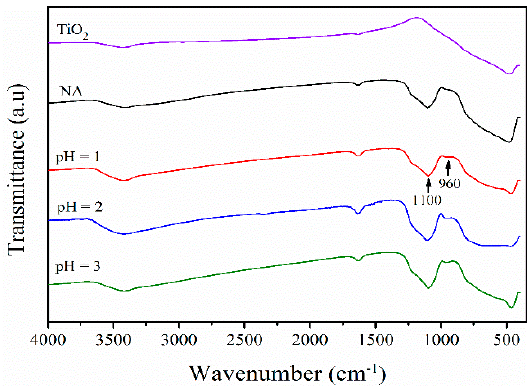
Figure 3. FT ‐ IR spectra of different synthetic BFS ‐ TiO 2 samples and commercial TiO 2 .